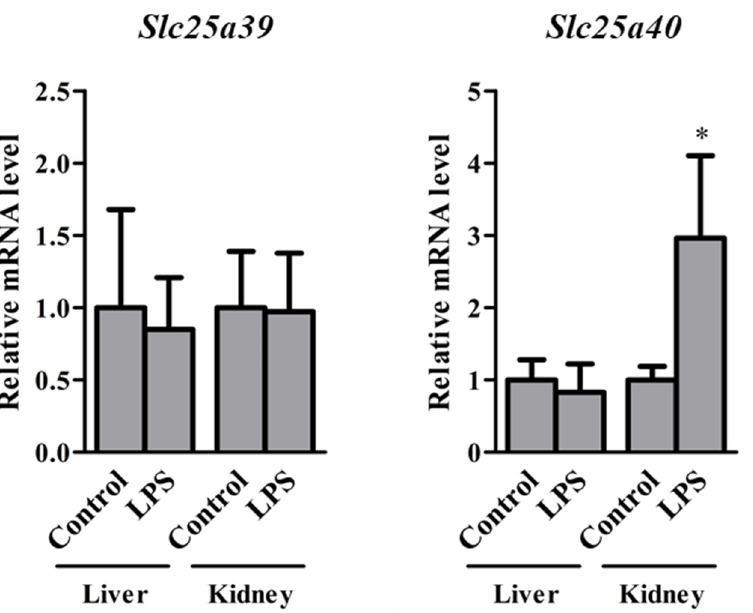
Figure 6. Relative mRNA levels of Slc25a39/40 in the liver and kidneys of control and lipopolysac- charide (LPS) mice 24 h after vehicle or LPS administration. The results are expressed as the mean ± S.D. of each group (n = 4 − 5). Signi fi cant di ff erences (* p < 0.05) between control and LPS mice were observed.